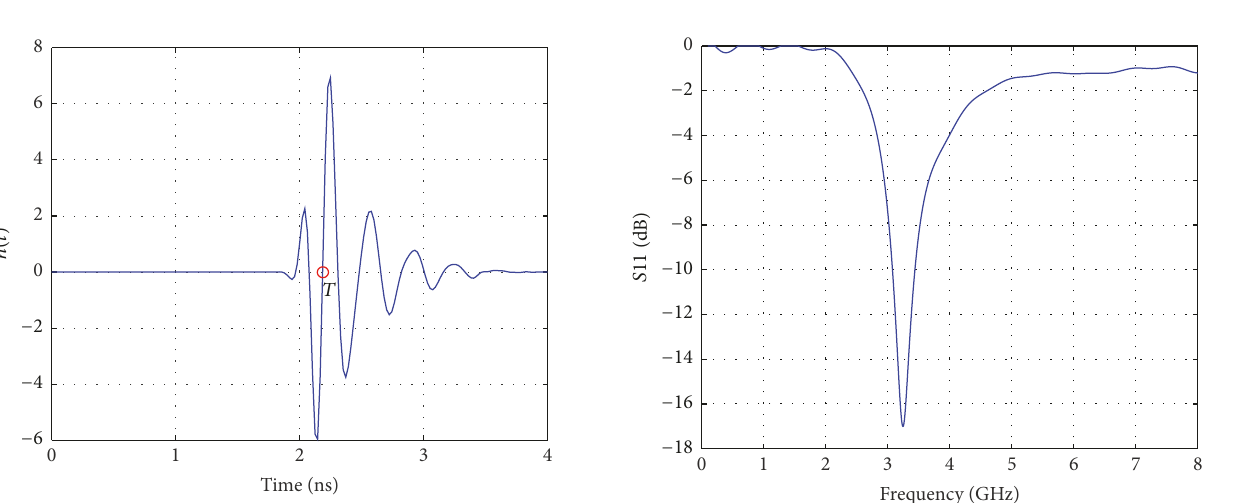
Figure 3: 𝑆 11 of the quarter-wave-length wire-monopole antenna.